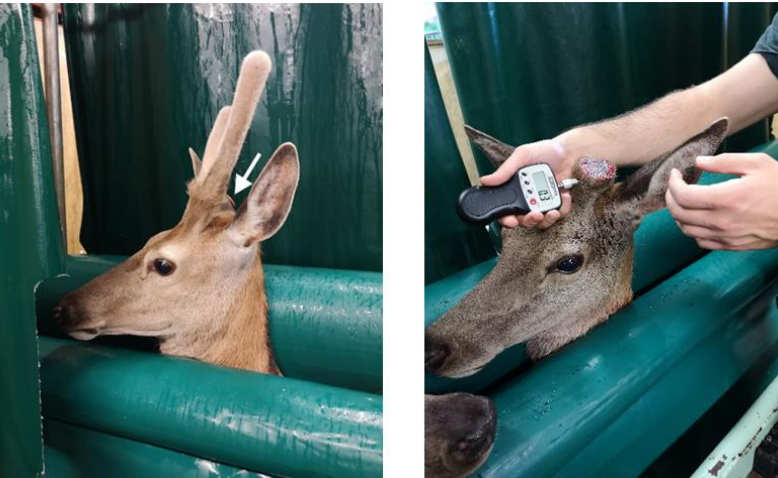
Figure 2. Left : Deer yearling showing early antler growth. Note the acute angle between the antler and the poll of the head. The white arrow indicates the site that the hand-held algometer was placed for the MNT measurements. Right : Pressure algometry in red deer using Wager ® hand-held algometer below the level of velvet antler removal. This picture illustrates the method used to measure force (N) at the cranial aspect of antler.